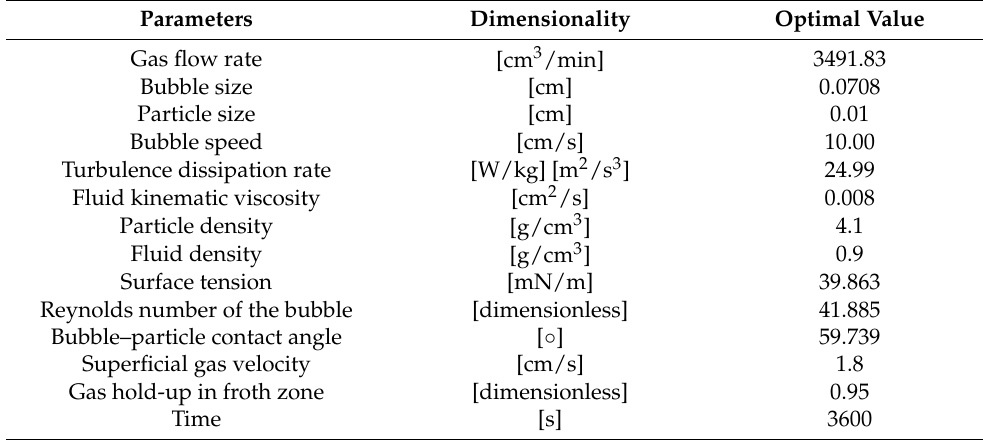
Table 4. Optimal levels of operating